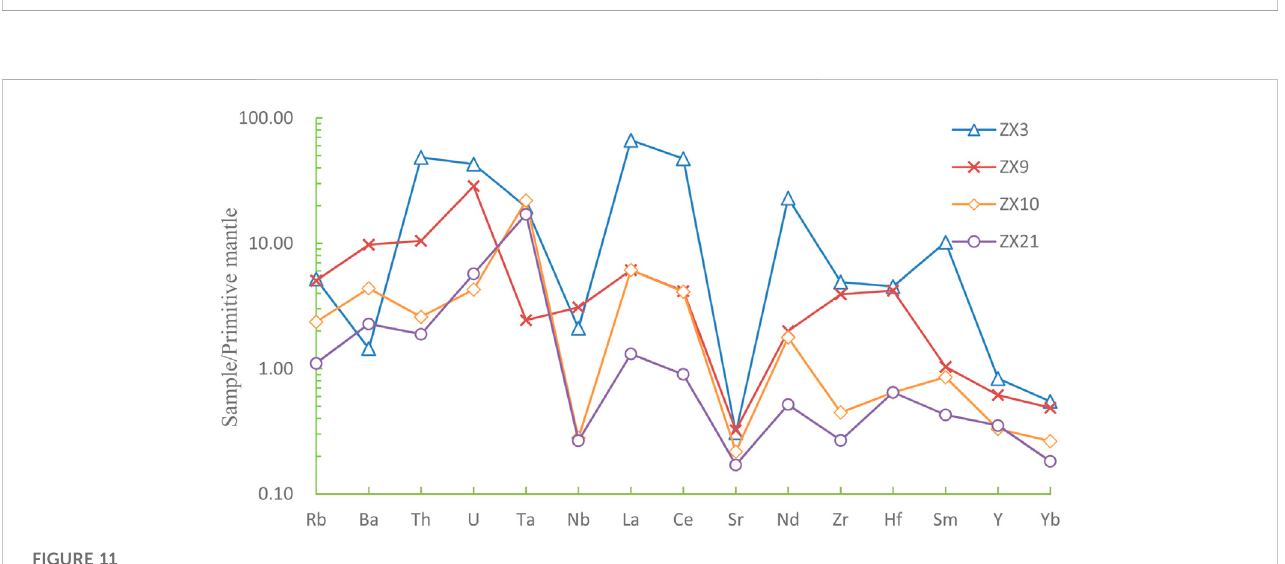
Frontiers in Earth